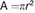
Gal/GalNAc lectin complex inhibits actin dot formation in Rab21CA.Trophozoites stably expressing Rab21CA were incubated for an hour with A. GalNAc on glass and fixed and stained for actin. B. Quantification of mean area of actin dots in Rab21CA formed on glass surface in presence of 100mM maltose and 100mM GalNAc. Mean diameter was manually measured using the motion tracking software (n = 150 actin dots/condition, total cells counted = 100) and area calculated, assuming the actin dot to be a circular object Α=πr2) and plotted using GraphPad Prism5. Graph shows mean ± SEM.***, P<0.001.C. Rab21 CA transformants were incubated on FN coated surface along with GalNAc for an hour at 35°C. Cells were fixed and stained for actin. D. Quantification of mean area of actin dots in Rab21CA formed on FN coated surface in presence of 100mM maltose and 100mM GalNAc (n = 690 actin dots/ 150 cells for 0mM GalNAc; n = 441 actin dots/ 180 cells for 100mM GalNAc; n = 700actin dots/ 220 cells for 100mM Maltose).Graph shows mean ± SEM.*, P<0.05. E. Similarly, trophozoites stably expressing Rab21CA were incubated with αHgl mouse MAb 3F4 (1:30) plated on glass for an hour at 35°C. Cells were fixed and stained for Hgl (green) and actin (red) and imaged using Zeiss LSM780. F. Quantification of mean area of actin dots in Rab21CA formed on glass surface in presence of αHgl 3F4 (n = 155 actin dots, 91 cells for treated with 3F4; n = 200actin dots, 100cells for untreated).Graph shows mean ± SEM. **, P<0.01. G. Trophozoites stably expressing Rab21CA were incubated with αHgl mouse MAb 3F4 (1:30) plated on fibronectin coated surface for an hour at 35°C. Cells were fixed and stained for Hgl (green) and actin (red) and imaged using Zeiss LSM780. H. Quantification of mean area of actin dots formed on fibronectin coated surface in presence of αHgl 3F4 (n = 590 actin dots, 105 cells for treated with 3F4; n = 450 actin dots, 98 cells for untreated). Graph shows mean ± SEM. *, P<0.05. Scale bars, 10μm.